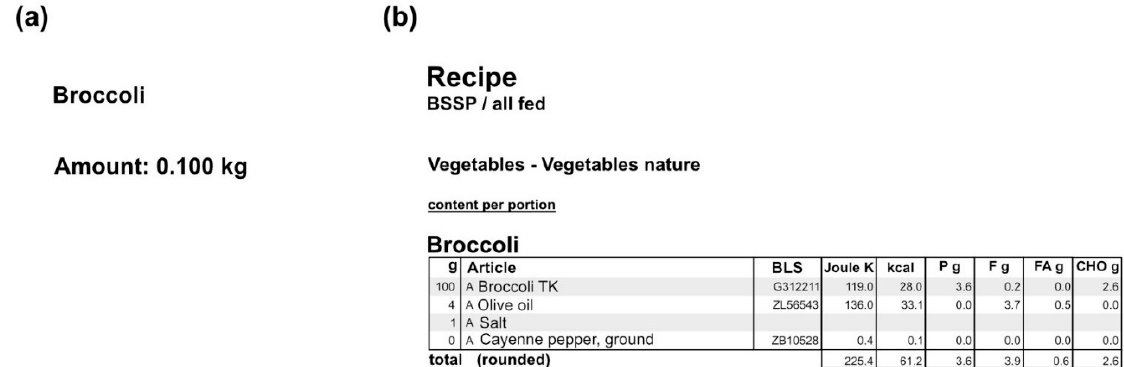
Figure 4. An example of exported pdf file from the kitchen database for the dish “Broccoli”: ( a ) the quantity of a normal-sized dish; ( b ) the macronutrients of a normal-sized dish (P: protein, F: fat, FA: fatty acids, CHO: carbohydrates).